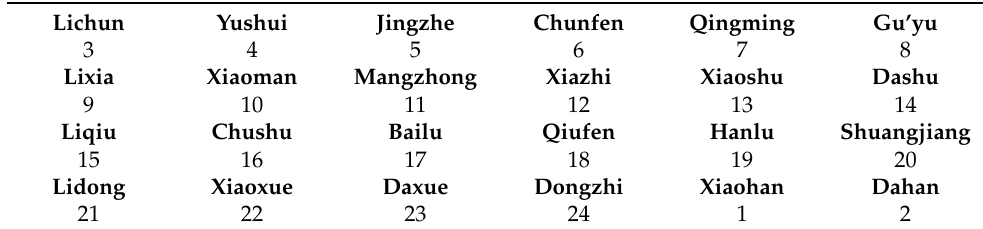
Table 1. Names and order of the 24 solar